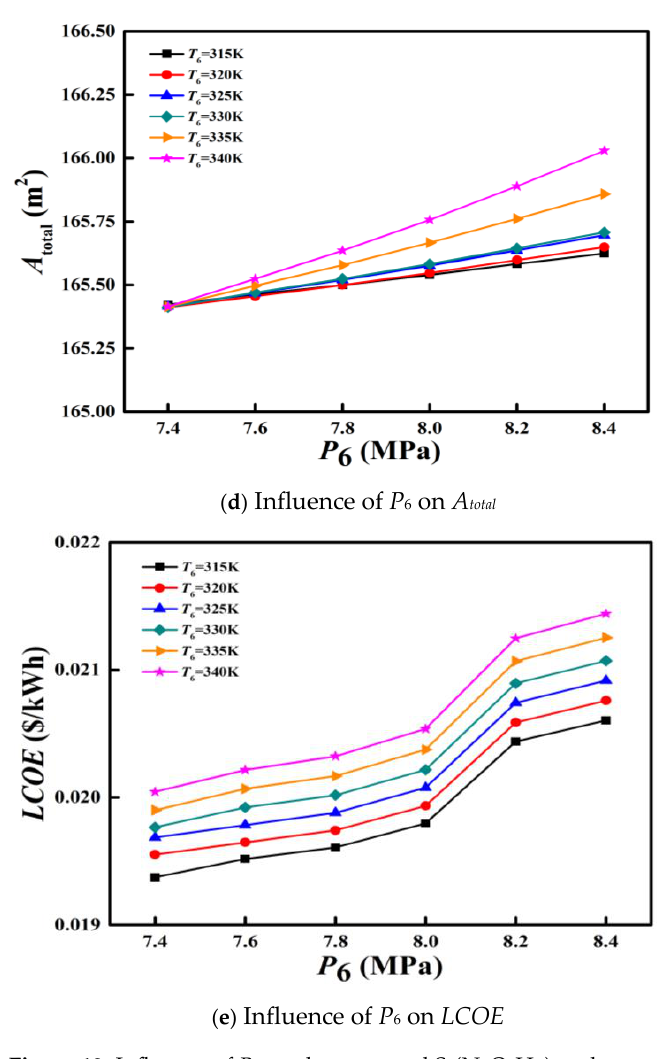
6 on the proposed S-(N 2 O-He)